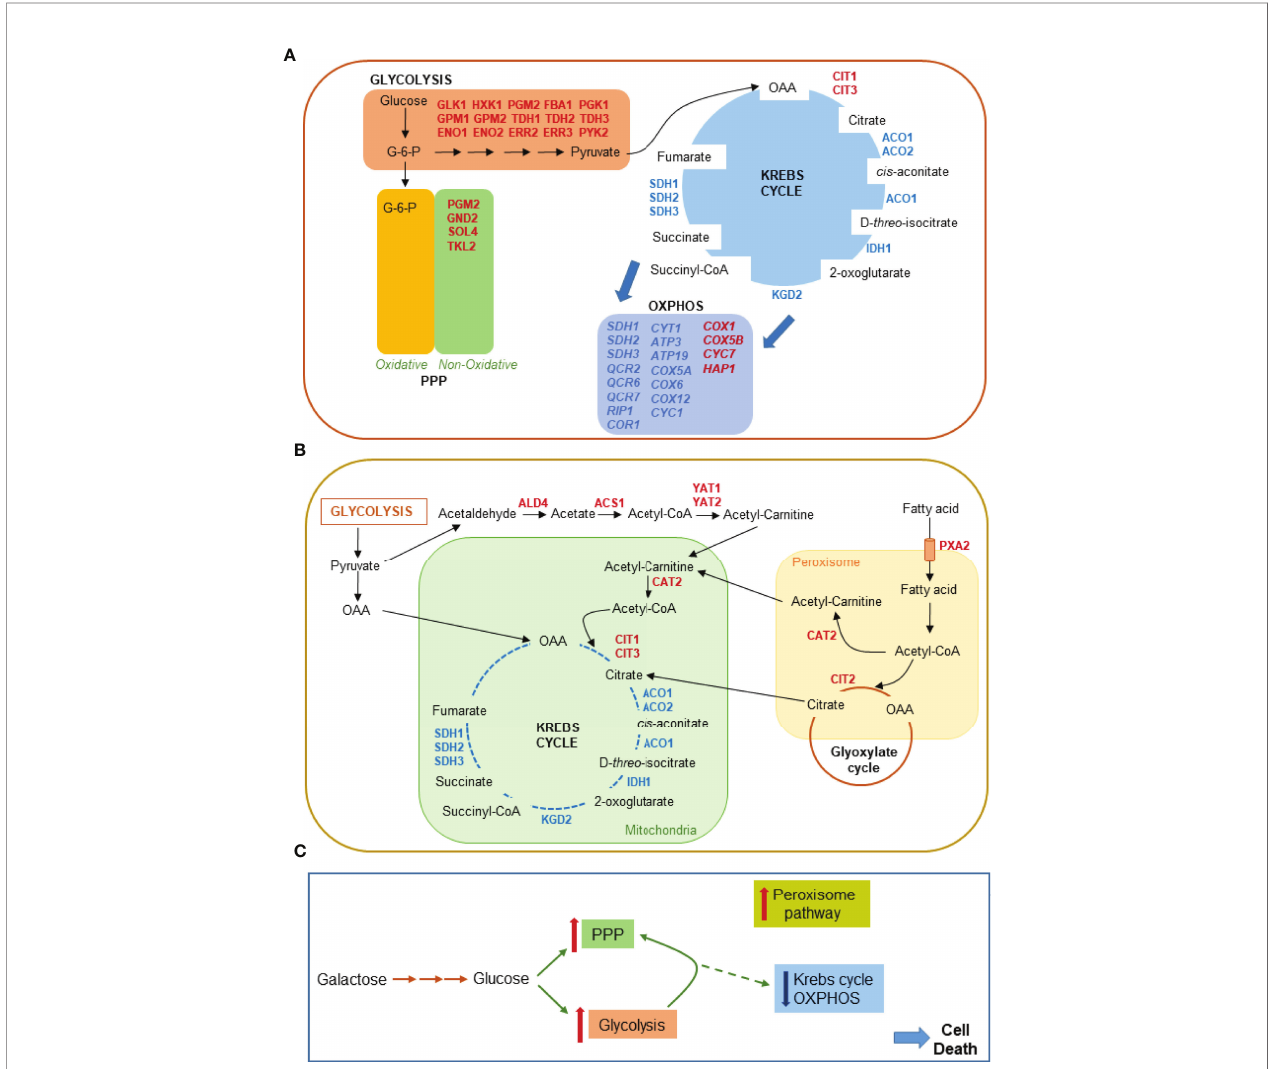
FIGURE 3 | Metabolic pathways affected by BRCA2 expression in yeast cells undergoing AA-RCD as inferred from RNA-seq transcriptomic pro fi ling. (A) 25 genes up-regulated in central carbon metabolism pathways, i.e., glycolysis, pentose phosphate pathway (PPP), Krebs cycle and oxidative phosphorylation (OXPHOS) are displayed in red. 23 genes down-regulated in Krebs cycle and OXPHOS are indicated in blue. (B) Mitochondrial RTG pathway target genes up-regulated in the cytosol, mitochondria and peroxisomes of AA-RCD cells expressing BRCA2 are displayed in red. Also included in the display in blue 8 genes downregulated in Krebs cycle as in (A) . (C) Krebs cycle and OXPHOS fl ux from glucose is strongly repressed (broken line) whereas glycolytic and PPP fl ux increases in yeast cells expressing BRCA2 en route to